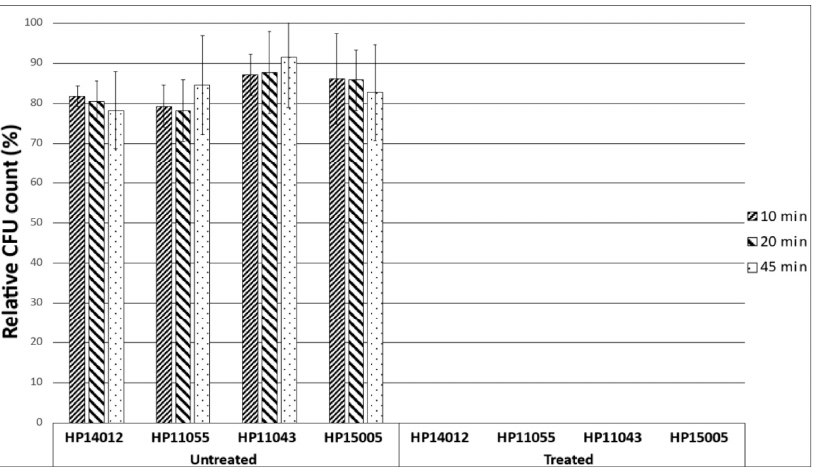
Figure 2. Time required for HerbELICO ® essential oils mixture to kill off H. pylori cells. The untreated group had no exposure to the HerbELICO ® essential oil mixture. The treated group had exposure to the 5% ( v / v ) HerbELICO ® essential oil mixture for 10, 20 and 45 min.